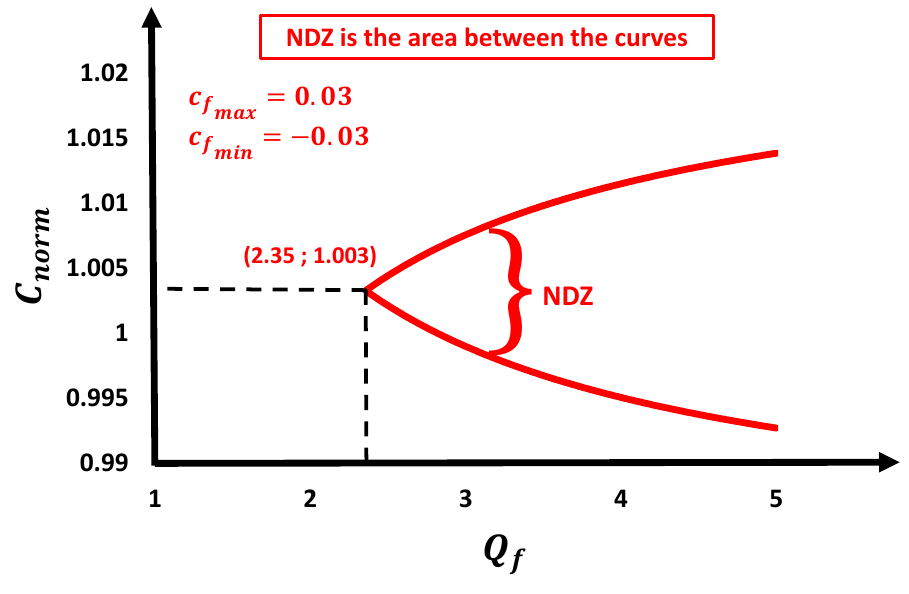
= 0.03 and c = − 0.03. f mini = 0.03 and 𝑐 = −0.03 . maxi 𝑓 𝑚𝑖𝑛𝑖 𝑚𝑎𝑥𝑖